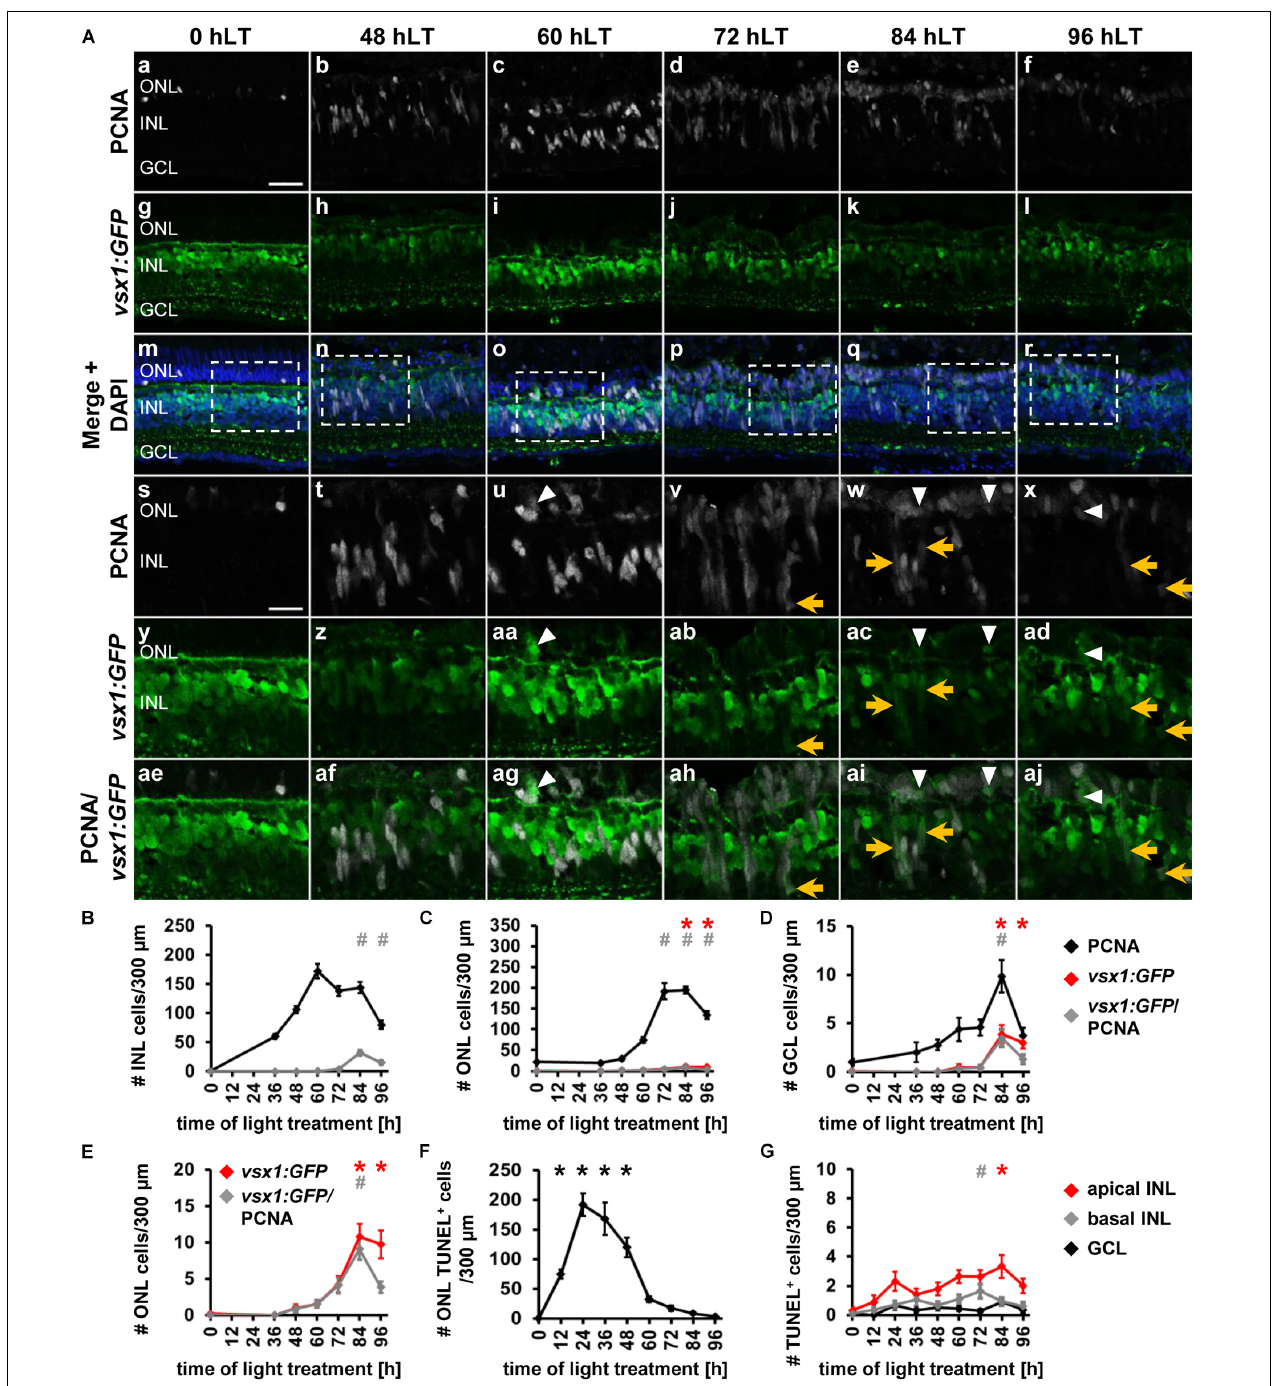
FIGURE 6 | Bipolar cell competence factor vsx1:GFP is expressed in proliferating cells in the light-damaged retina. (Aa–aj) Single z-plane confocal images of retinal sections from light-damaged TgBAC[vsx1:GFP]nns5 z ebrafish (0, 48, 60, 72, 84, 96 hLT) immunolabeled for PCNA (Aa–f,Am–x,Aae–aj) , GFP (Ag–r,Ay–aj) and counterstained with DAPI (Am–r) . (As–aj) Regions outlined in panels (Am–r) at higher magnification. Scale bars, 20 µ m (Aa) and 10 µ m (As) . (B–D) Number of PCNA-positive, vsx1:GFP -positive and PCNA and vsx1:GFP -double positive cells in the INL (B) , ONL (C) , and GCL (D) over the light treatment timecourse. (E) Number of vsx1:GFP -positive and vsx1:GFP and PCNA − double positive cells in the ONL at a different scale. (F,G) Number of TUNEL-positive cells in the ONL (F) and in the inner retina (G) , (apical INL, basal INL, GCL) following constant intense light treatment for 0, 12, 24, 36, 48, 60, 72, 84 and 96 h. Mean ± SE, n ≥ 10. * p Tukey < 0.05 and # p < 0.05 indicate comparisons to 0 hLT for the different measures that were assessed. The symbols are color-coded according to the line that they represent in the corresponding graphs ( p ANOVA , see Table 1 ). Note, significance was not determined for PCNA in panels (B–D) .